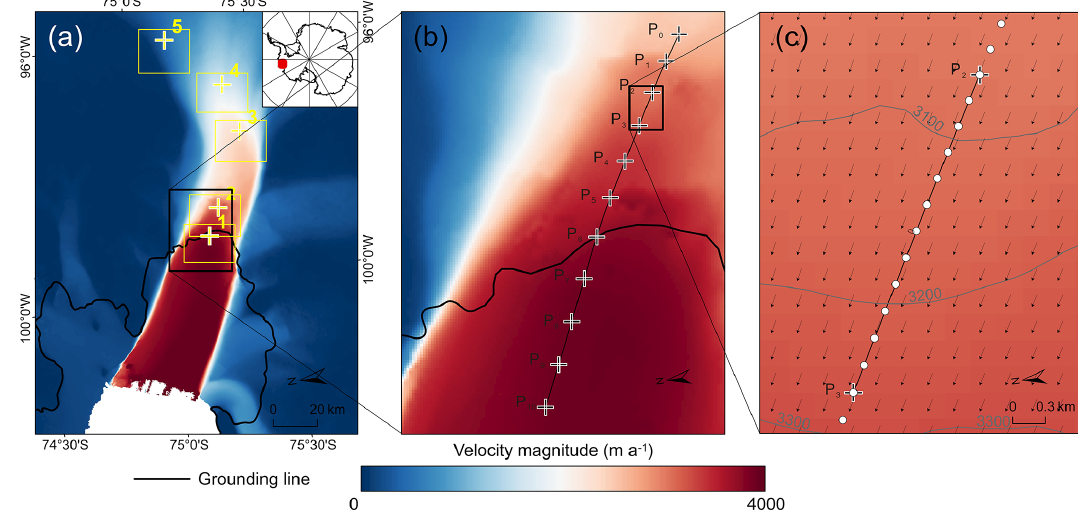
Figure 3. Implementation of numerical integral and L velocity calculation in Pine Island Glacier, West Antarctica: (a) black rectangle indicates the area of 10-year trajectory in panel (b) , numbered yellow rectangles with crosses are five selected areas in Experiment 3 (Fig. A3), and background is a 1-year velocity map (Gardner et al., 2018); (b) enlarged trajectory area with annual points from P 0 to P 10 ; and (c) numerical integral of the third-year sub-trajectory from P 2 to P 3 with a monthly increment.